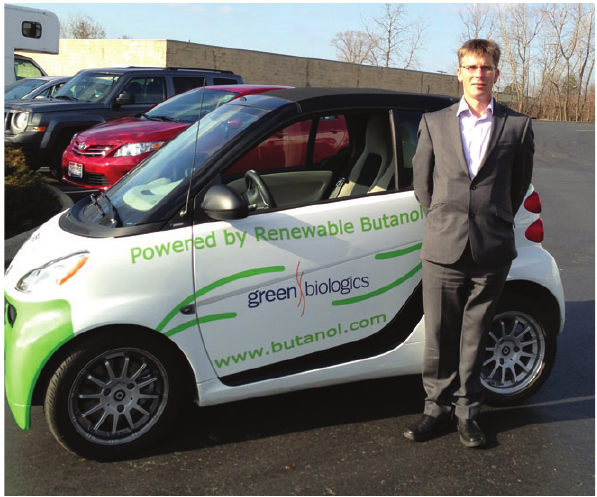
Figure 4 Edward Green, founder with the Green Biologics Smart car, run exclusively on